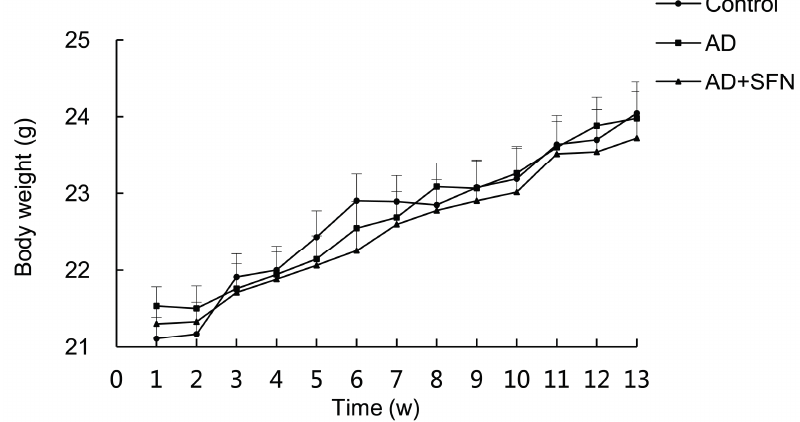
Figure 1. Measurement of mice body weight. During the treatment, no significant difference in body weight was observed among control, Alzheimer’s disease-like (AD-like) mice and sulforaphane-treated Alzheimer’s disease-like (AD + SFN-like) mice ( n = 18; mean ± S.E.M.; One-way analysis of variance followed by post hoc least significant difference multiple comparison tests).